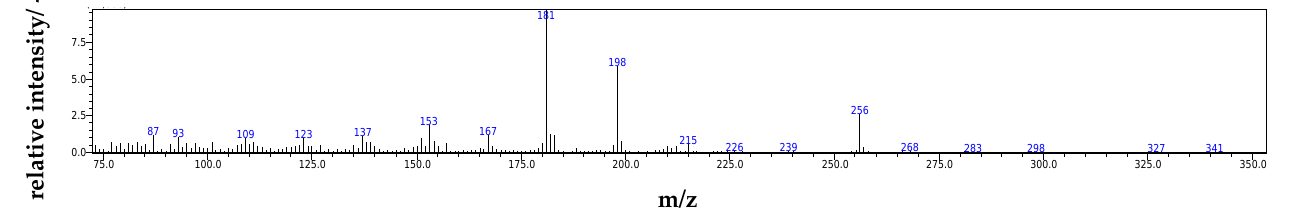
Figure 6. Mass spectrum of the compound identified as probably syringic acid acetate.